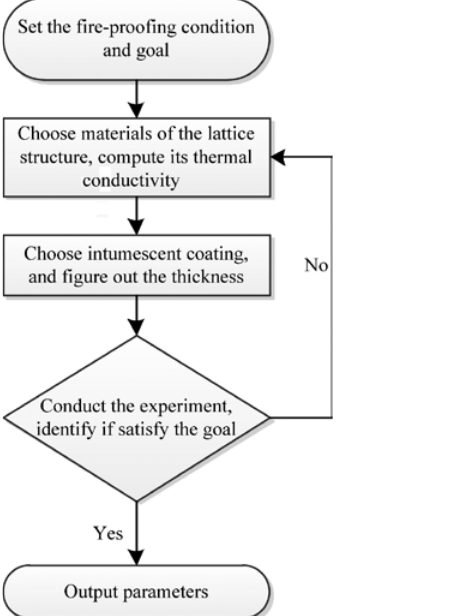
Figure 4: Design procedure of the fire-proofing composite lattice sandwich structure.